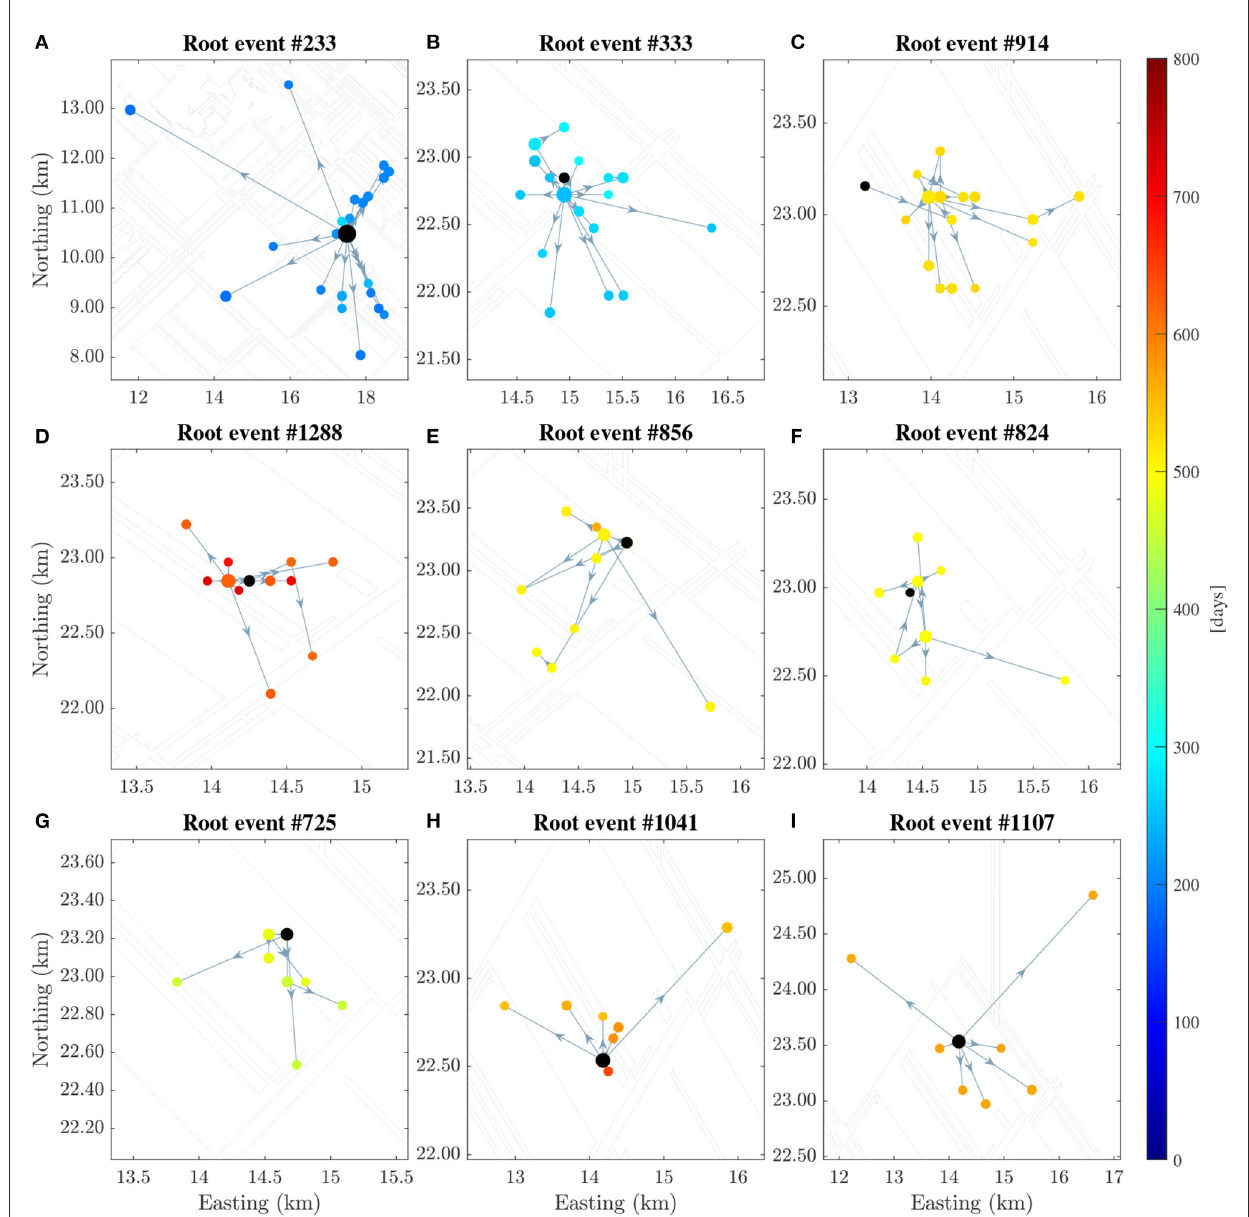
FIGURE11 The spatial distribution of the nine largest clusters with respect to the mine layout. The panels from (A)-(I) correspond to the clusters initiated by the root events (the black solid circles) indicated by their numbers in the